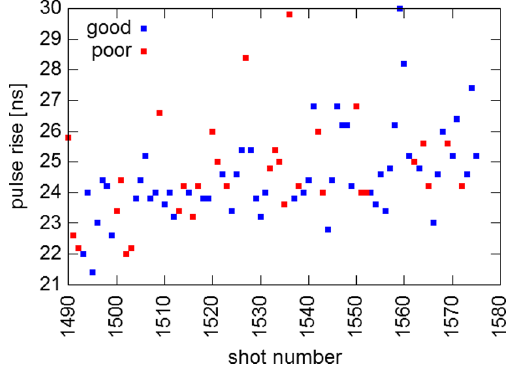
FIG. 11. The pulse rise from OF versus shot number. Good shots are shown in blue and poor shots in red. The rise is calculated as the time to rise from 10% to 90% of the mean OF current.